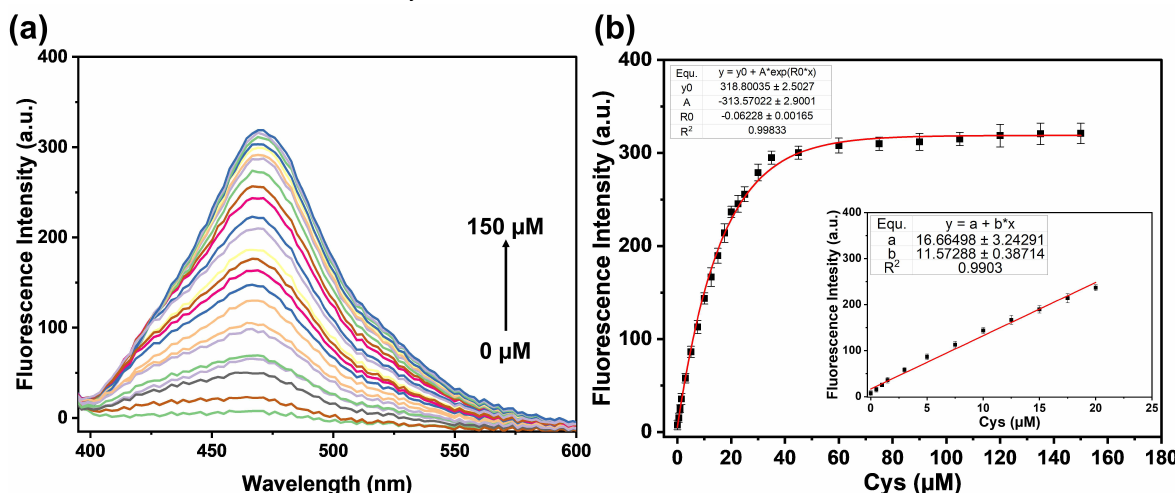
Figure 6. ( a ) Changes in fluorescence spectra of ABIA (10 µ M, λ ex = 370 nm) recorded using CysDDev upon the successive addition Cys (0–150 µ M) in urine at pH = 7.3 ( b ) Calibration curves for the detection of Cys in urine using ABIA and CysDDev ( λ ex = 370 nm, λ em = 455 nm) Inset is the linear regression curve in the range of 0–20 µ M of